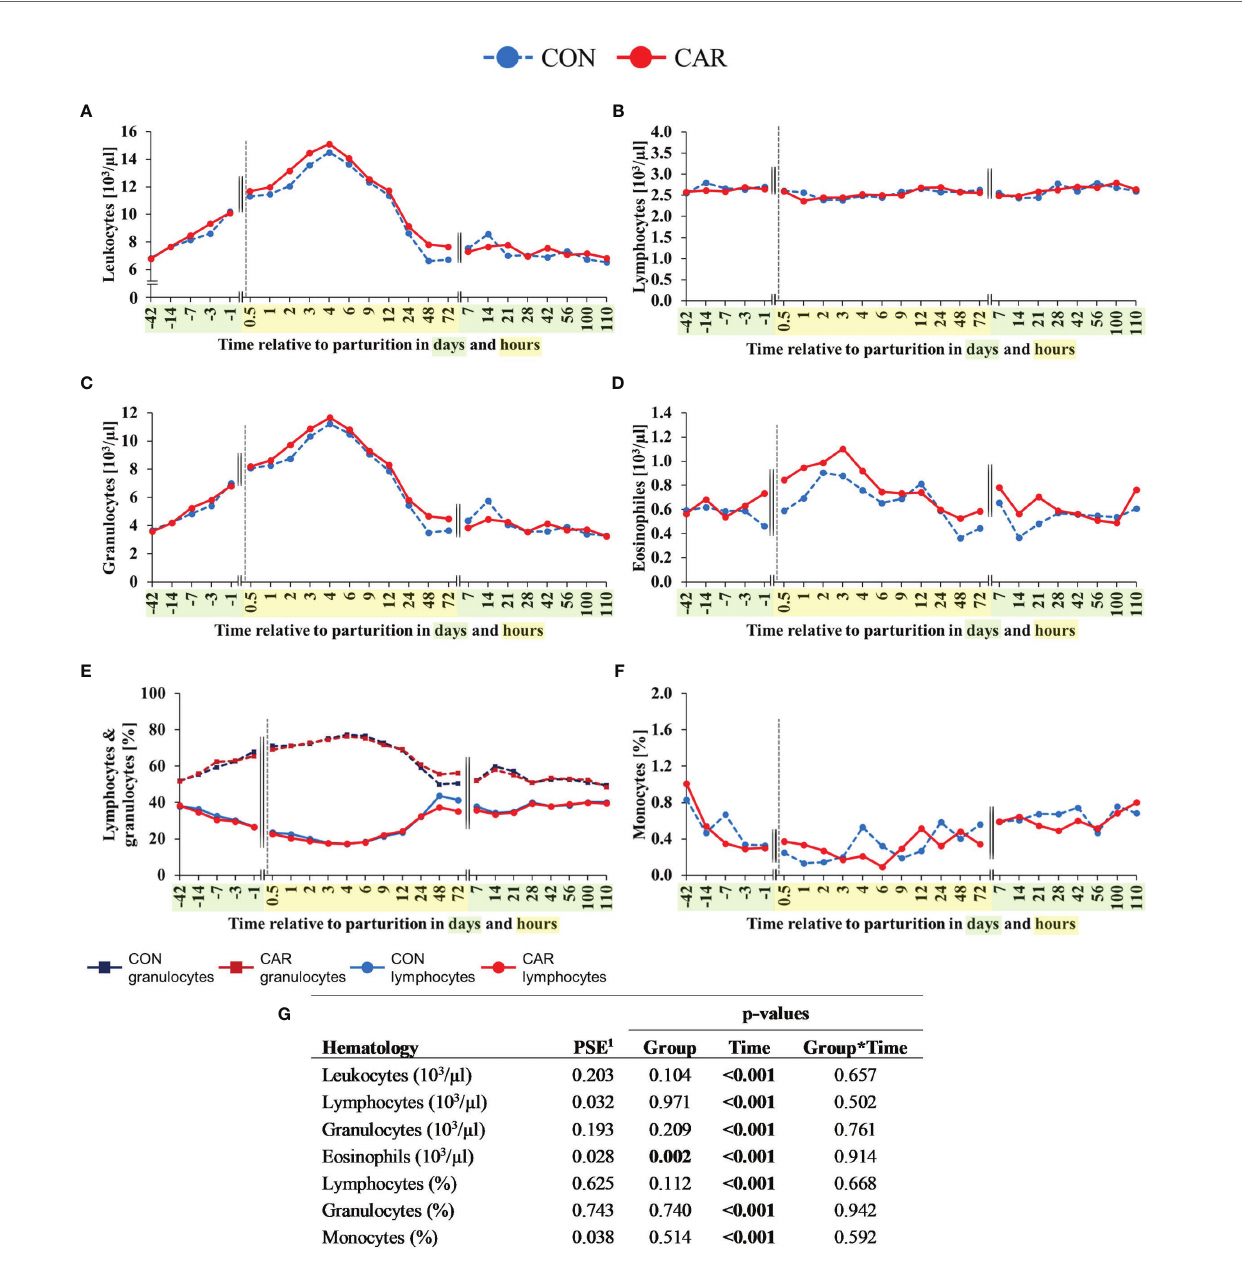
FIGURE 3 | White blood cell counts of dairy cows fed a diet supplemented with (CAR) or without (CON) L-carnitine from 6 weeks before until 15 weeks after calving. (A) total leukocyte count, (B) lymphocyte count, (C) granulocyte count, (D) eosinophil count, (E) percentage of lymphocyte and granulocyte and (F) percentage of monocytes are determined by an automated cell analyzer. (G) Data statistics. Data are shown as least square means. 1 pooled standard